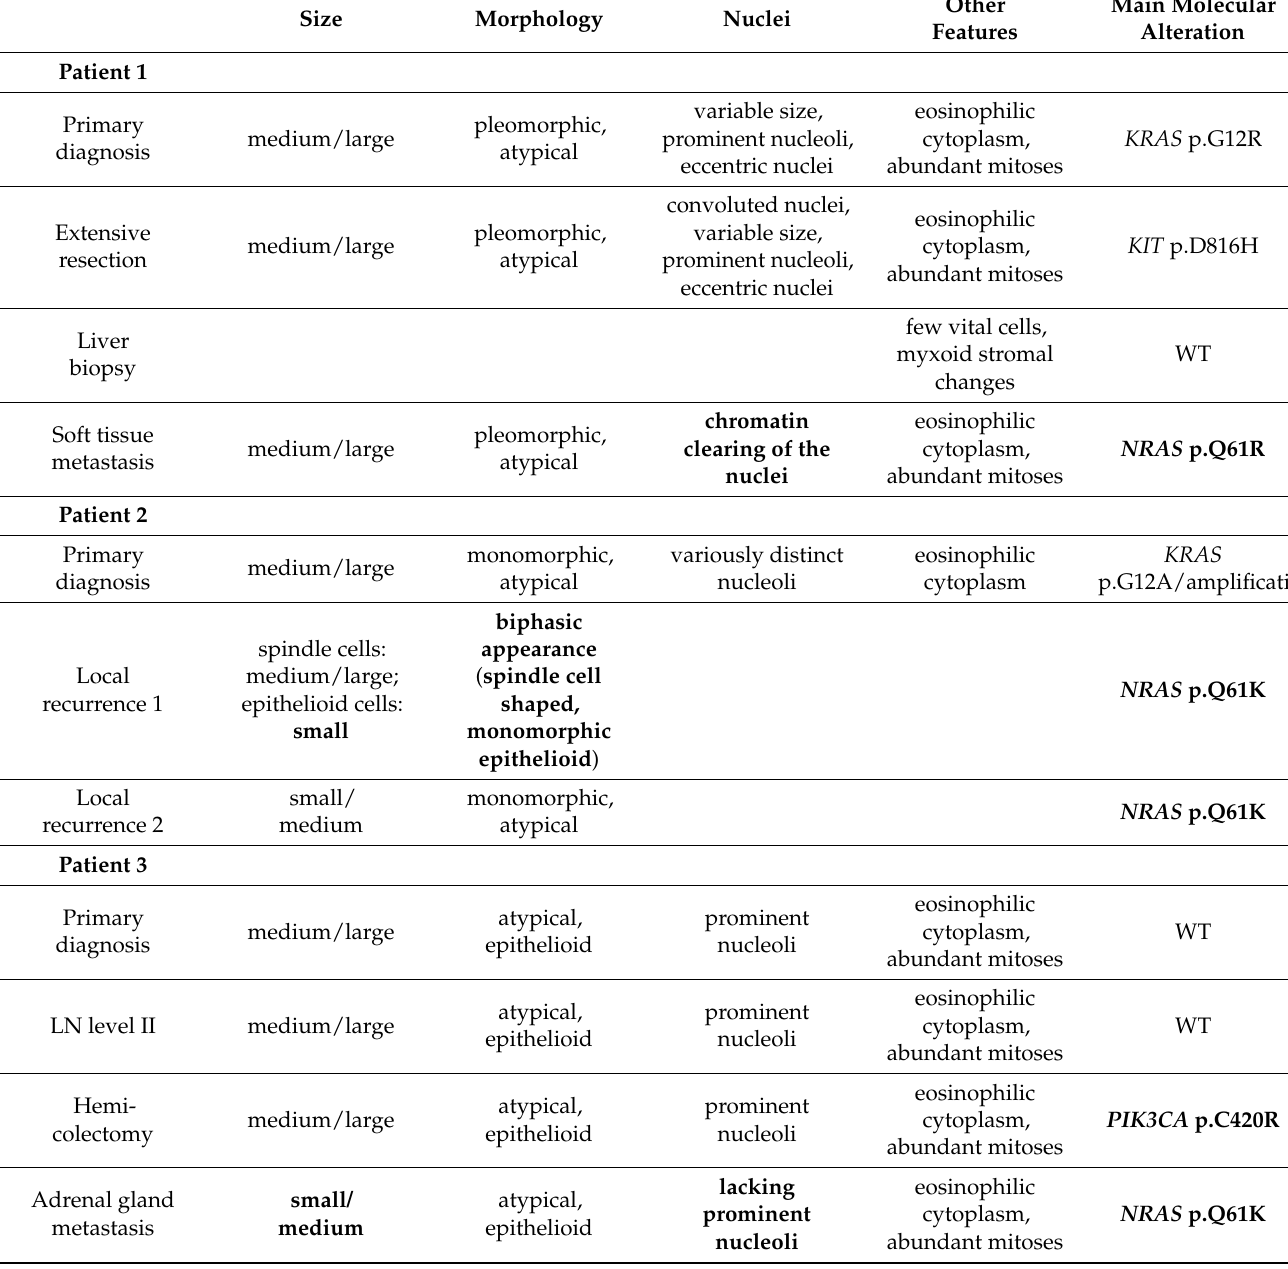
Table 2. Comparison of tumor